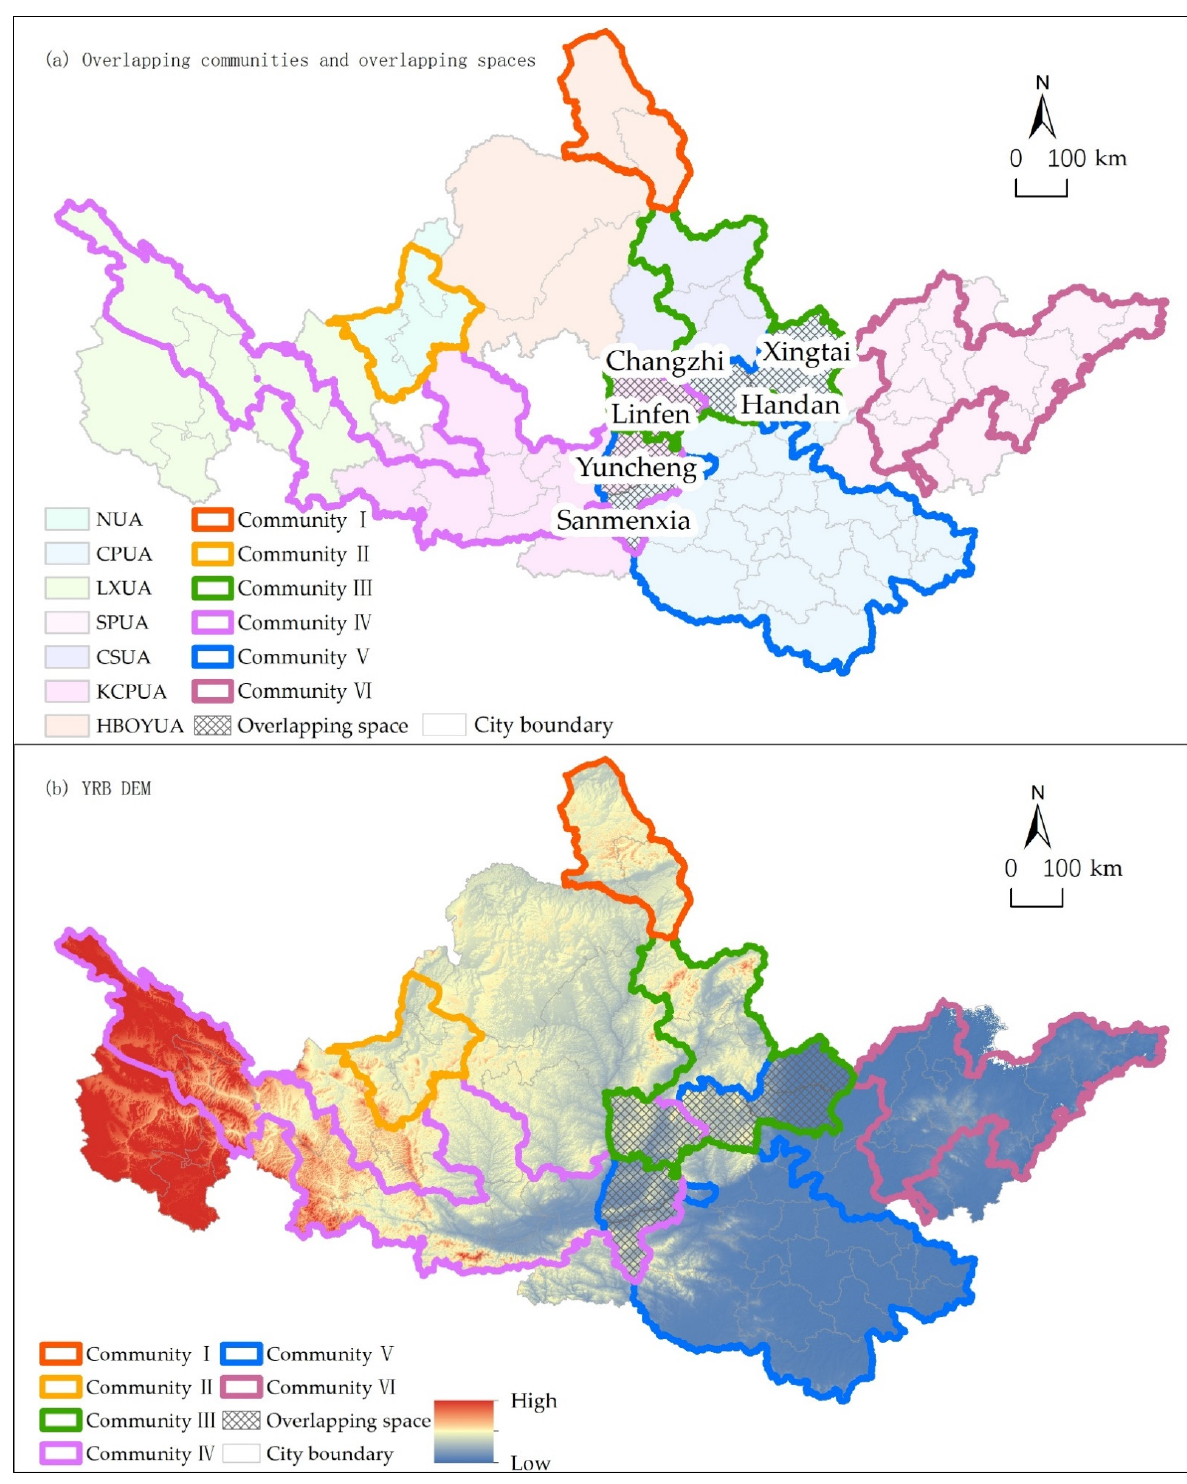
Figure 7. Spatial division of urban overlap in the Yellow River Basin. The overlapping space of Sanmenxia was located in central CSUA, KCPUA, and the peripheral area of CPUA, while also establishing a spatial connection between the